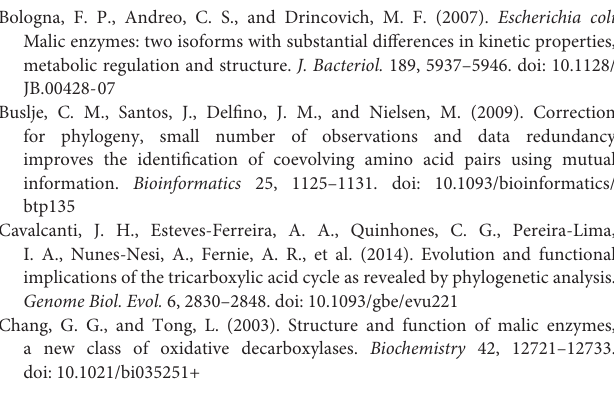
sequence alignment conservation (from red to cyan, red: the most conserved positions and cyan: the less conserved ones). The fourth circle shows MI scores as histogram. Lines in the center of the circle connect pairs of positions with MI score > 6.5. Red lines represent the top 5%; black lines are between 70 and 95%, while gray lines account for the last 70%. Outer red bars indicate regions with the largest number of MI connections, while sequence insertions A, C, D, and F are highlighted in blue. (B) Interactive framework showing part of the MI network between residues surrounding, or located in, the sequence insertions. Ovals with letters indicate residues located in insertions A, C, D, and F. (C) Interactive framework showing part of the MI network between residues from different subunits. Ovals include residues exhibiting MIs that are shown in the Logo panel. Asterisks indicate the amino acid residue taken as a reference for the exemplified MI network. Logo panels show the amino acid frequency of occurrence along with the corresponding MI value. FIGURE S3 | Exon structure in plant and animal NAD(P)-MEs . (A) Alignment of the predicted amino acid sequences of all ME family members in H. sapiens , X. laevis , D. rerio , and C. livia . Fragments encoded by different exons in the amino acid sequence are shown in colors and numbered from E1 to E14. Highlighted sequences indicate mitochondrial targeting peptide. (B) Alignment of the predicted amino acid sequences of all ME family members in P. patens (three cNADP-ME and one mNAD-ME), S. moellendorffi (two cNADP-ME and one mNAD-ME), A. thaliana (three cNADP-ME, one plNADP-ME, and two mNAD-ME), and Z. mays (three cNADP-ME, two plNADP-ME, and two mNAD-ME). Fragments encoded by different exons in the amino acid sequence are shown in colors and numbered from E0 to E19 for NADP-ME or from e1 to e19 for NAD-ME. Highlighted sequences denote plastidic or mitochondrial targeting peptides. FIGURE S4 | Bayesian 50% majority-rule consensus tree of Class I-ME protein sequences. Evolutionary history was inferred based on the WAG + G + I model. The main lineages are compressed and designated by their name. Nodes with BBP support > 0.95 are indicated next to each branch. The area of the triangles representing collapsed clades is not proportional to the number of taxa within the clade. The red section in animal clade represents chromist sequence insertion and the gray section in chromist clade represents fungi sequences. FIGURE S5 | Genes potentially originated from photosynthetic organisms in R. oryzae and M. circinelloides. Phylogenetic tree using ML method (WAG model) of amino acid sequences. In all cases, numerals indicate boostrap support of branches using 100 replicates. Branch length is proportional to sequence changes. Color line indicates cyanoacteria, red alga, or fungal sequences. These genes were selected based on the photosynthesis-related homologous present in Phytophthora sojae (Tyler et al., 2006). TABLE S1 | Accession number of MEF sequences used in this work. ∗ Indicate sequences used for identity calculation in Figure 1 . The sequences of MEs, MLEs and OADs were recovered from the National Center for Biotechnology Information database (http://ncbi.nlm.nih.gov). For plants and algal species with entire genome information MEs sequences were extracted from www.phytozome.net, while animal and fungal MEs were retrieved from www.genomesize.com and http://fungidb.org,